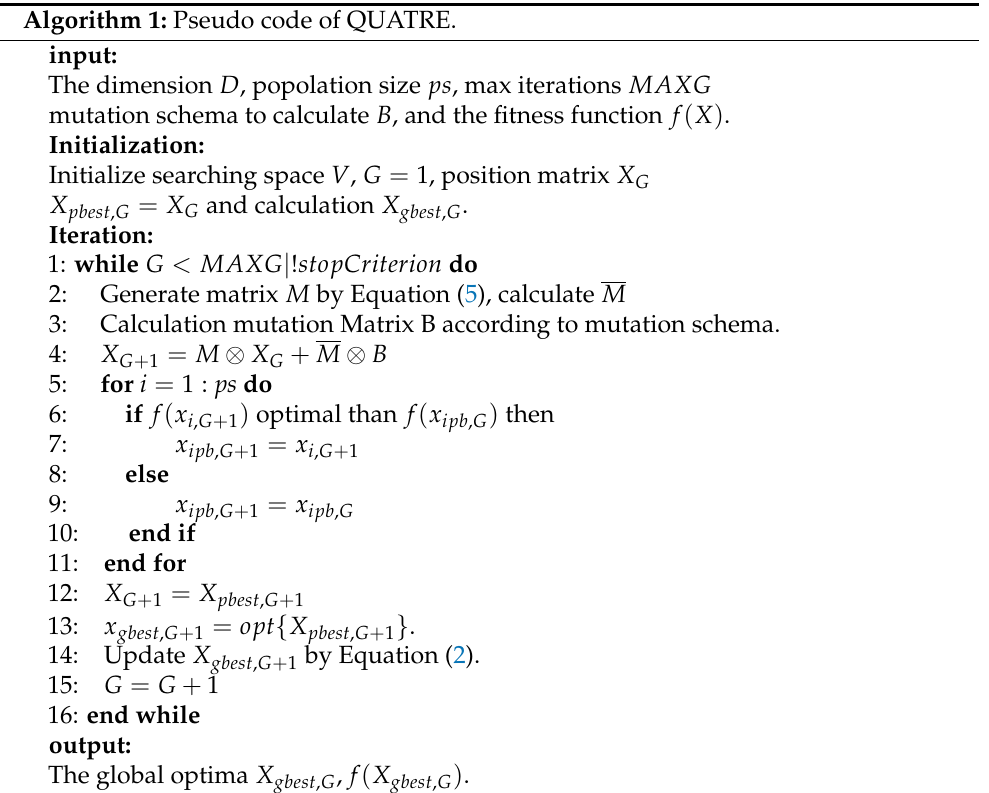
Algorithm 1: Pseudo code of